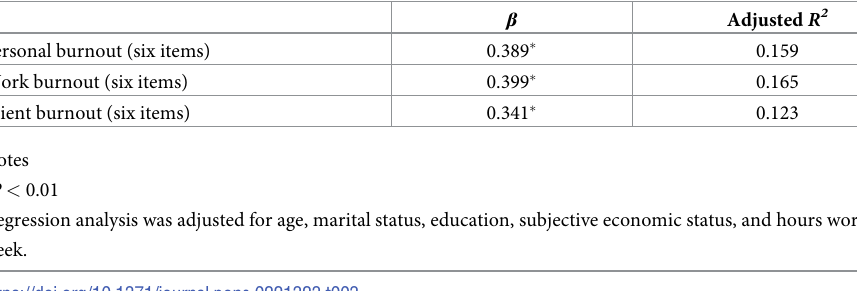
Table 3. The association between the revised Korean version of the Copenhagen Burnout Inventory and depres- sive symptoms among Korean care workers working with elderly community-dwelling individuals (N =